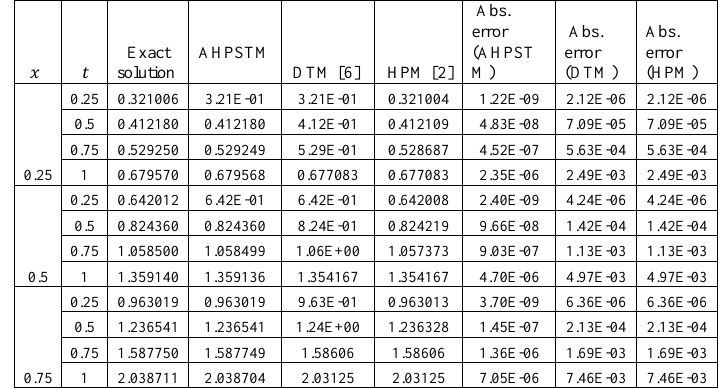
Table 2: Approximate solution of Eq. (11) up to 4 th order approximation